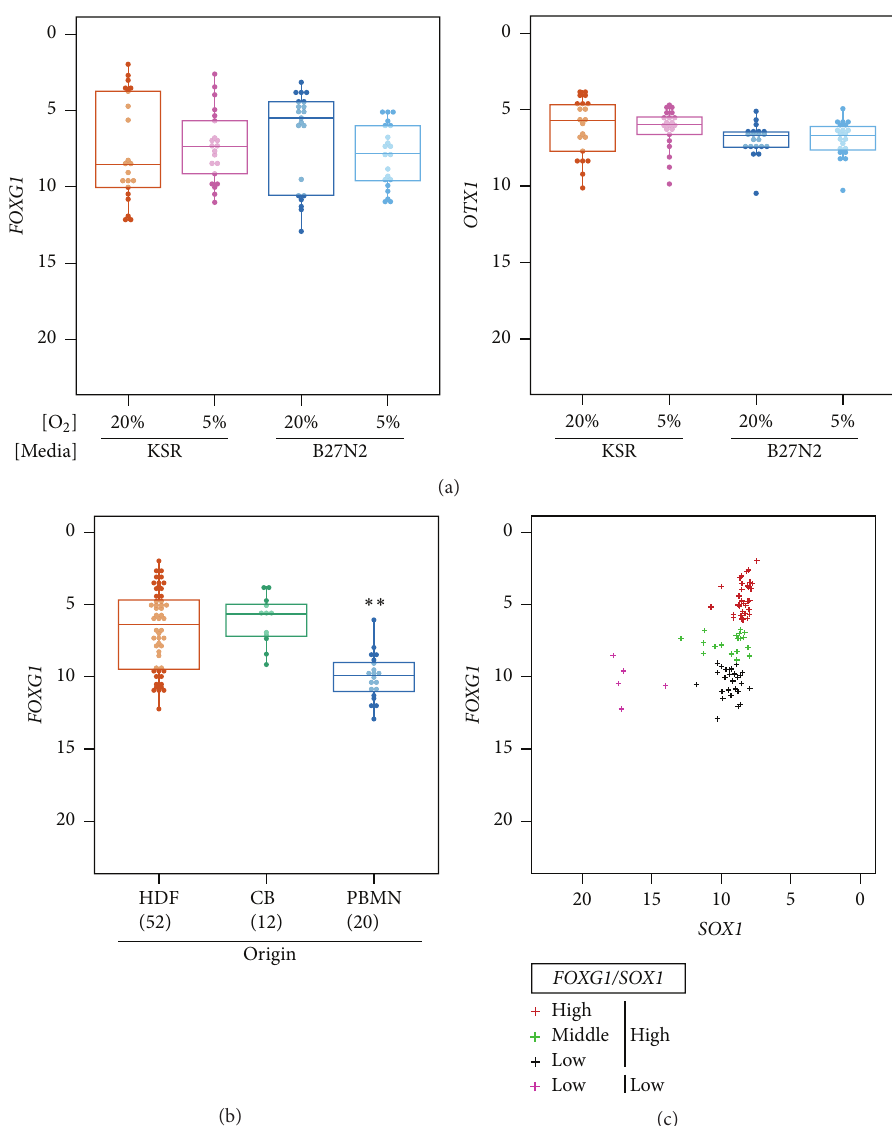
Figure 3: PBMN-derived neural aggregates exhibit low FOXG1 expression levels. (a) Dot plots and box plots showing FOXG1 and OTX1 expression in day 14 neural aggregates cultured in the various conditions. (b) Dot plots and box plots showing the FOXG1 expression levels according to tissue origin. The number of clones analyzed is indicated in parentheses. Statistical analysis was performed by the Steel-Dwass test. ∗∗ 𝑝 < 0.01 . (c) Clustering of clones, based on the expression of FOXG1 and SOX1 , using the 𝐾 -medoids method. The delta Ct values are indicated by “+” symbols. Four clusters were identified: FOXG1 -high/ SOX1 -high (red), FOXG1 -middle/ SOX1 -high (green), FOXG1 -low/ SOX1 - high (black), and FOXG1 -low/ SOX1 -low (pink). See also Table